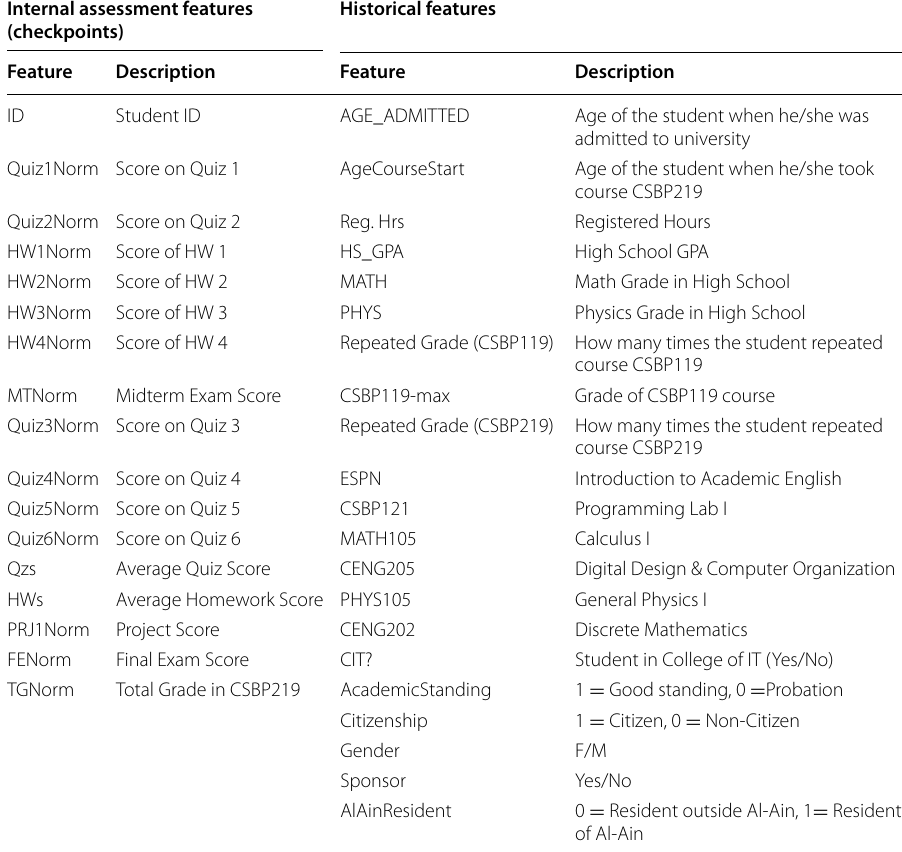
Table 1 Dataset features Internal assessment features